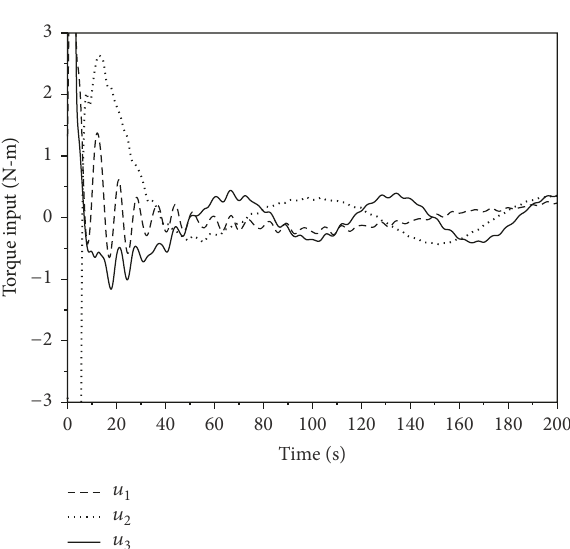
Figure 5: First and second modes under